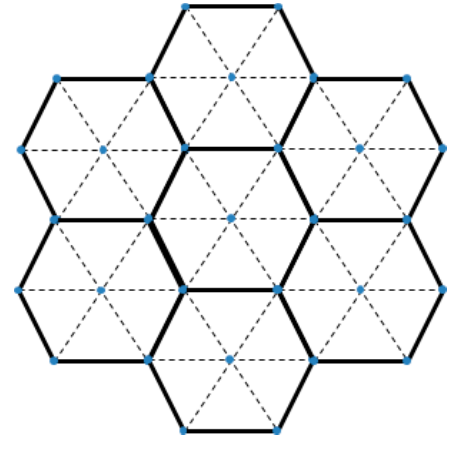
Figure 2. Indoor Space Partitioning for a Large Space.